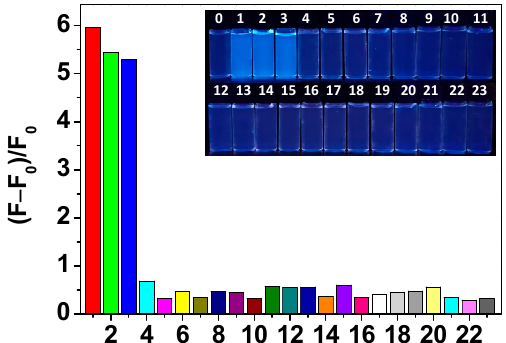
Figure 4. Normalized fluorescence responses of L -Cu 2 + (10 µ M) in the DMF / HEPES mixed solution (7:3, v / v , Ph = 7.4) in the presence of various analytes (70 µ M): 1. GSH, 2. Hcy, 3. Cys, 4. acetylcysteine, 5. thiophenol, 6. sulfide, 7. bisulfate, 8. Val, 9. Ala, 10. Met, 11. Pro, 12. Thr, 13. Trp, 14. Gly, 15. Lys, 16. Phe, 17. Ser, 18. Asn, 19. His, 20. Gln, 21. Leu, 22. Try, 23. Arg. The intensities were recorded at 443 nm, excitation at 378 nm. Inset: the fluorescence colour responses of L -Cu 2 + (10 µ M) in the presence of various analytes (70 µ M) under 365 nm UV light.